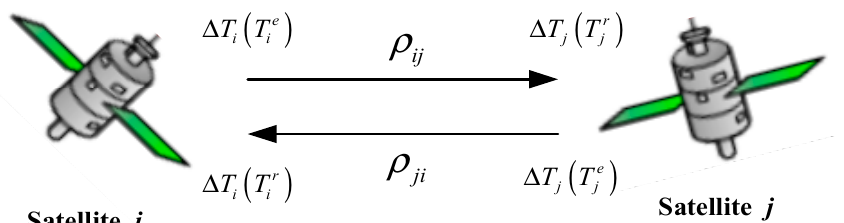
Figure 2. Schematic diagram of inter-satellite time synchronization.